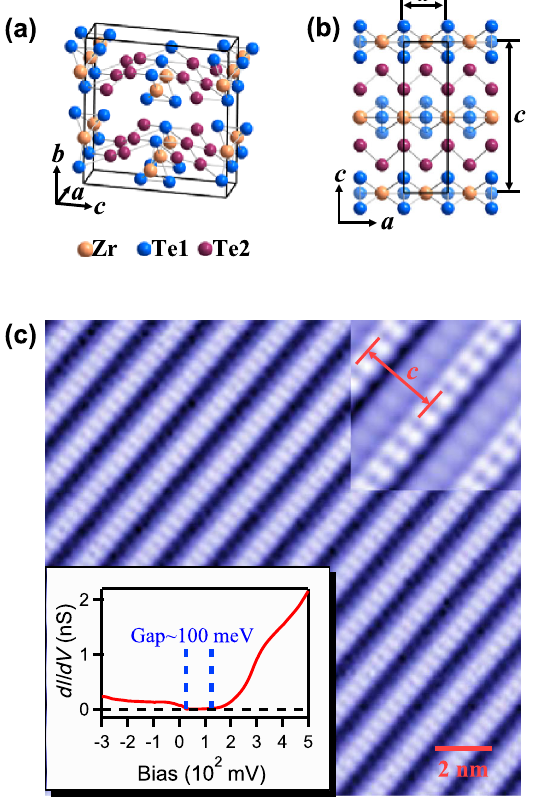
direction.FIG. 1. (a) 3D structure of ZrTe 5 crystal. (b) Top view of the single-layer structure. (c) STM constant current topographic image of the cleaved a - c (010) surface of ZrTe 5 crystal ( I ¼ 100 pA, V ¼ − 800 mV). Right top inset: High-resolution topography ( I ¼ 50 pA, V ¼ 400 mV) showing the details of the surface structure. Bottom left inset: Tunneling differential conductance spectrum on the a - c surface ( I ¼ 500 pA, V ¼ 500 mV) showing a large energy gap of ∼ 100 meV above E F with zero conductance inside the